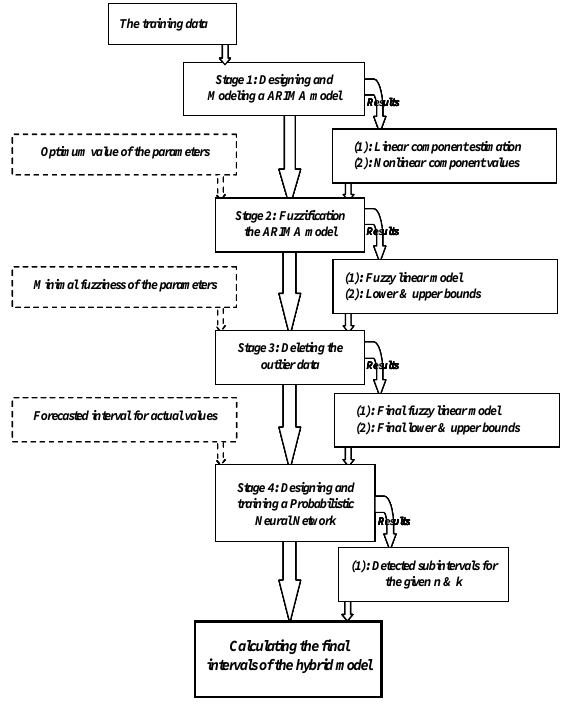
Fig. 2. The flowchart of the hybrid proposed